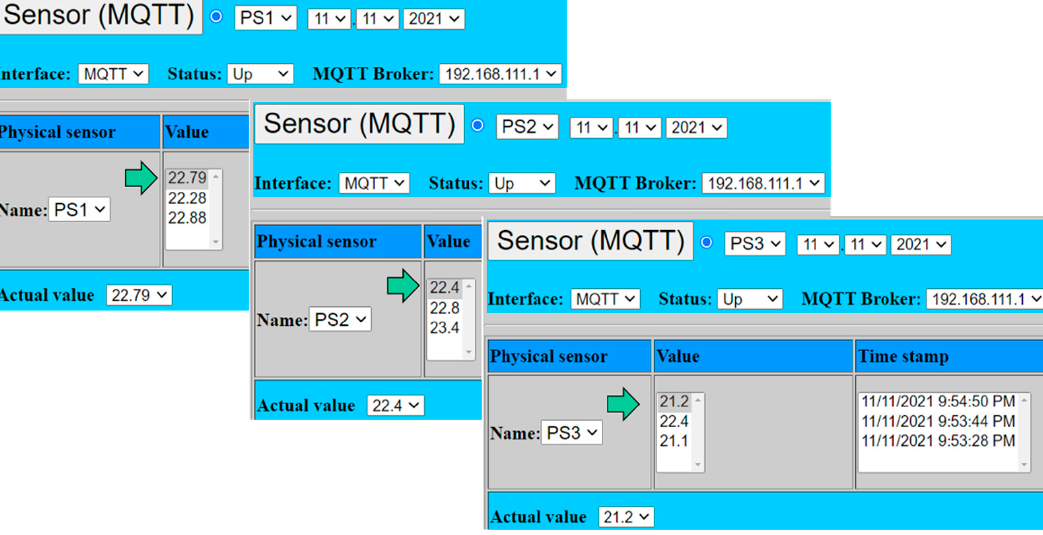
Figure 12. Emulated physical sensors connected to virtual sensor.